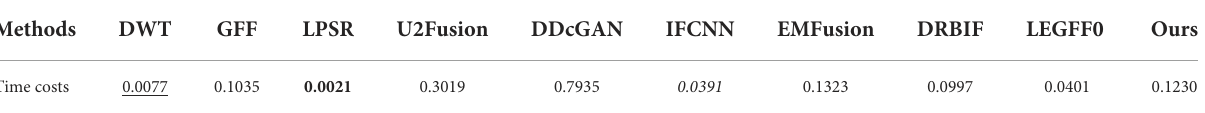
TABLE 4 Time cost